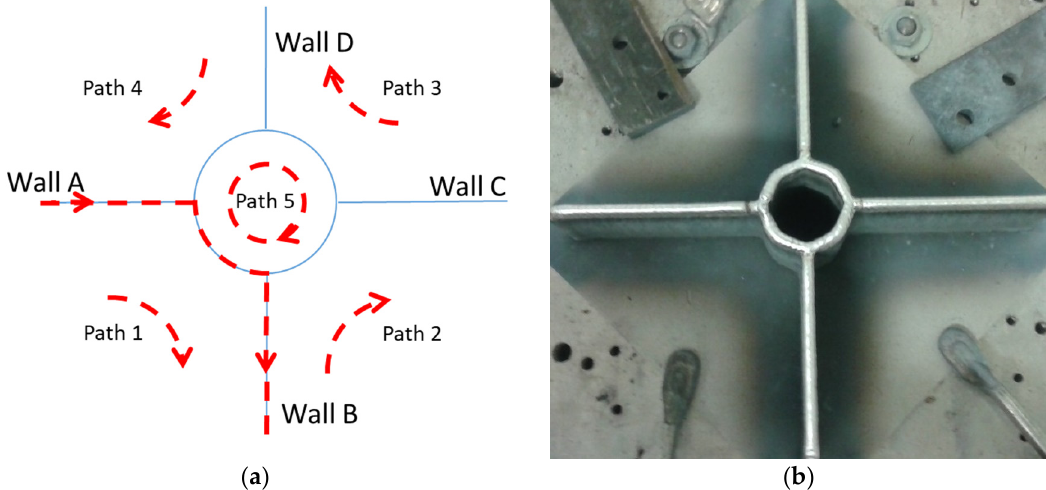
Figure 9. Roundabout-type intersection for two walls crossing: ( a ) manufacturing paths and ( b ) manufactured intersection.